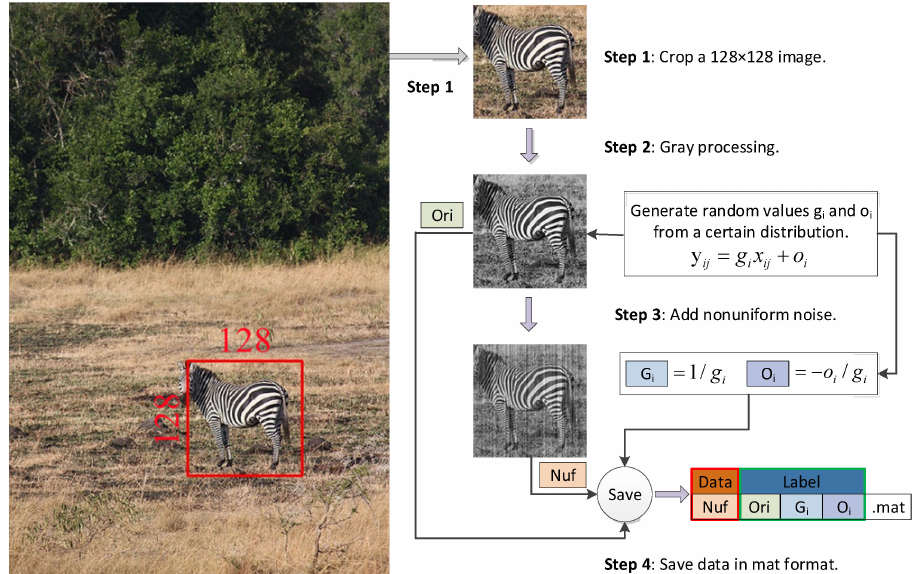
Figure 1. The specific operation of producing the datasets.